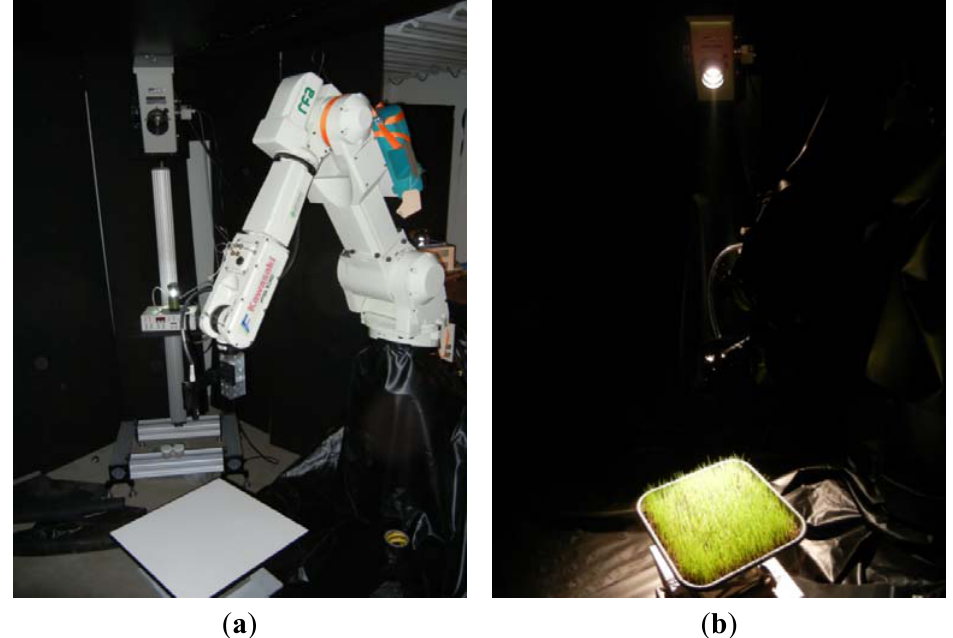
Figure 1. ( a ) Laboratory set-up with a Spectralon reference panel before covering the instruments with black materials; ( b ) laboratory set-up during the measurements: the walls are covered with panels that are painted with black latex and the floor, ceiling and the robot are covered with black PVC